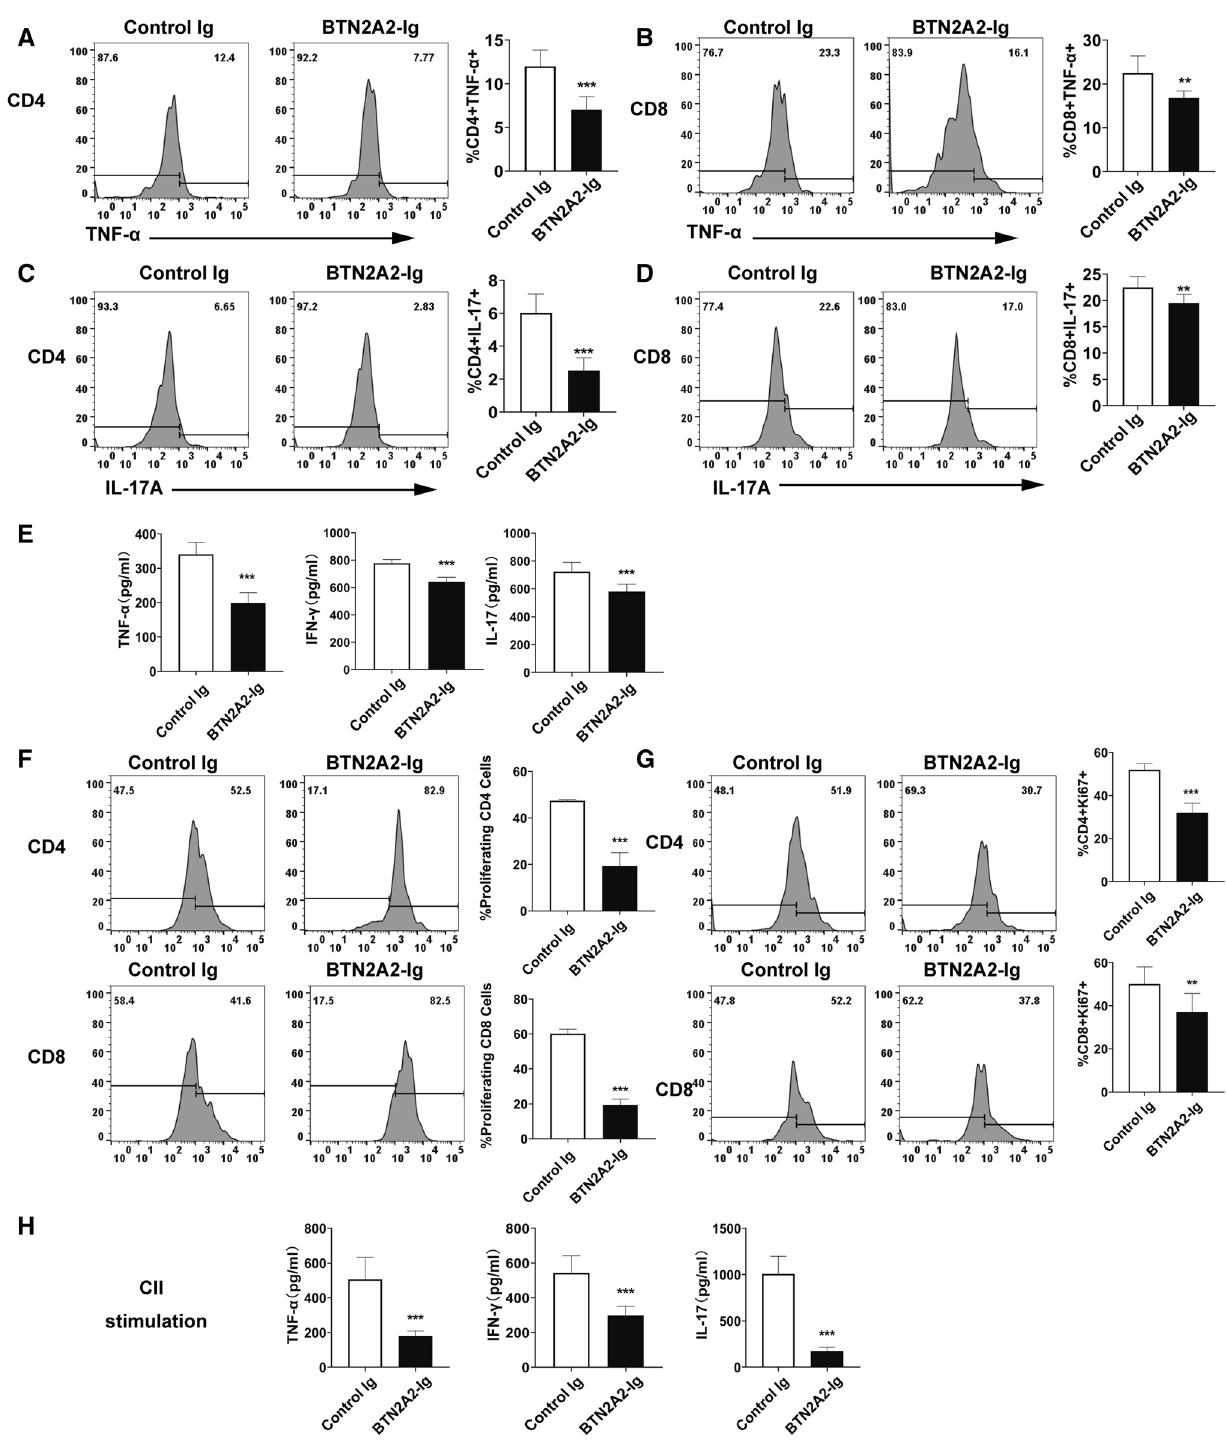
Figure 6. BTN2A2-Ig reduces Th1 and Th17 cytokine production in CIA mice. DBA/1J CIA mice were treated with mBTN2A2-Ig or control Ig as in Fig. 5. The percentages of cytokine—producing CD4 and CD8 T cells were analyzed by flow cytometry. The representative flow cytometric profiles and statistics analysis of ( A , B ) TNF-α + or ( C , D ) IL-17A + T cells. ( E ) The levels of TNF-α, IFN-γ, or IL-17A in the serum were measured by ELISA. ( F – H ) Splenocytes from CIA mice treated with BTN2A2-Ig or control Ig were cultured with 30 μg/ml of CII in vitro for 72 h. ( F , G ) T cell proliferation was analyzed by ( F ) CFSE dilution assay or ( G ) Ki67 staining. ( H ) The levels of IL-17A, TNF-α and IFN-γ in the supernatant were analyzed by ELISA. The data are expressed as the mean ± SD and representative of three independent experiments with similar results. (n = 6 each experiment each group) *** P < 0.001 compared with control Ig-treated